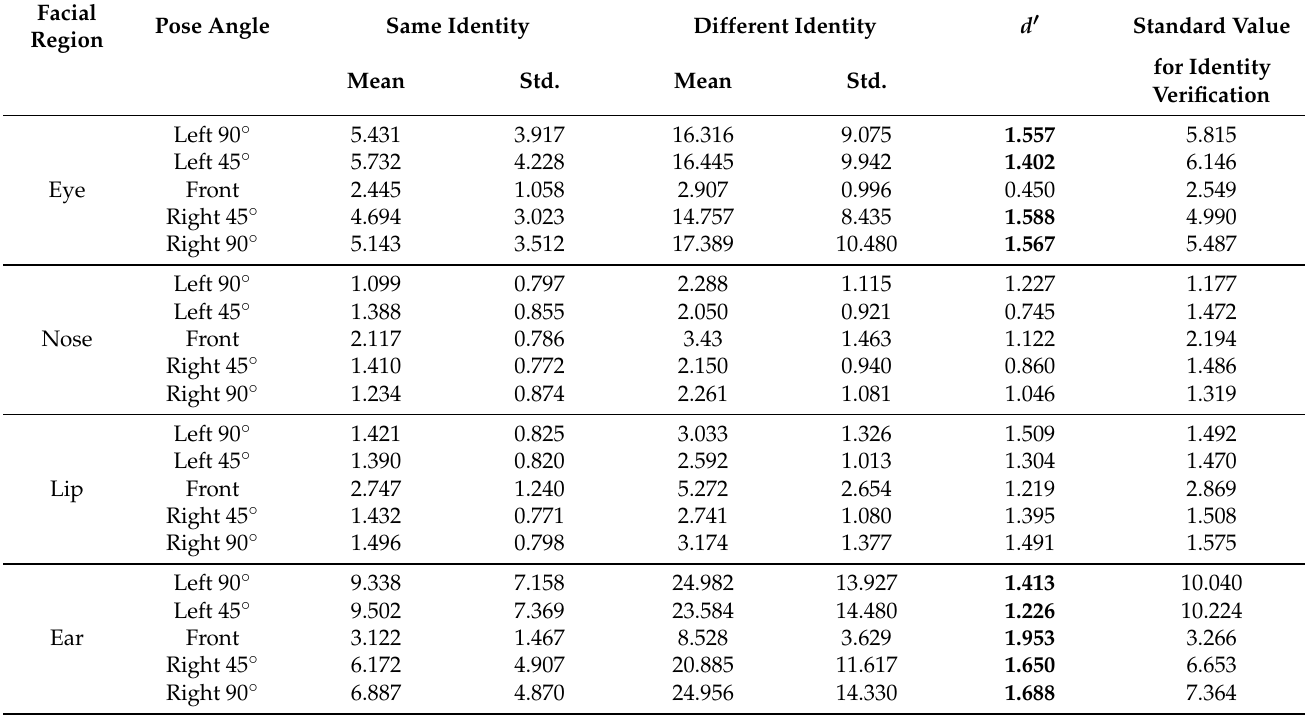
Table 5. Mean and Std. of EDs between reciprocal landmarks in each